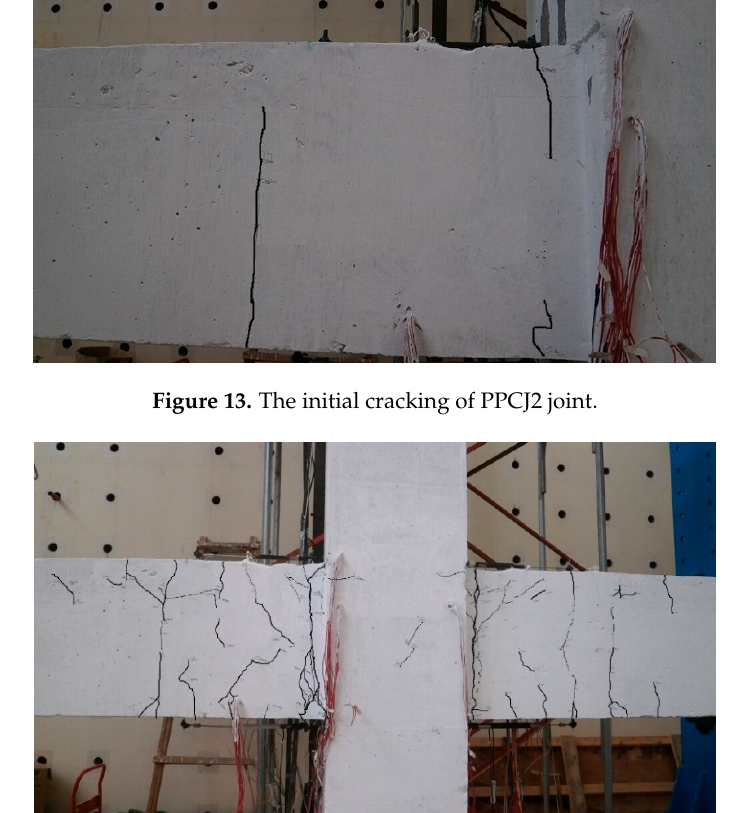
Figure 15. Final damage of the PPCJ2 joint.